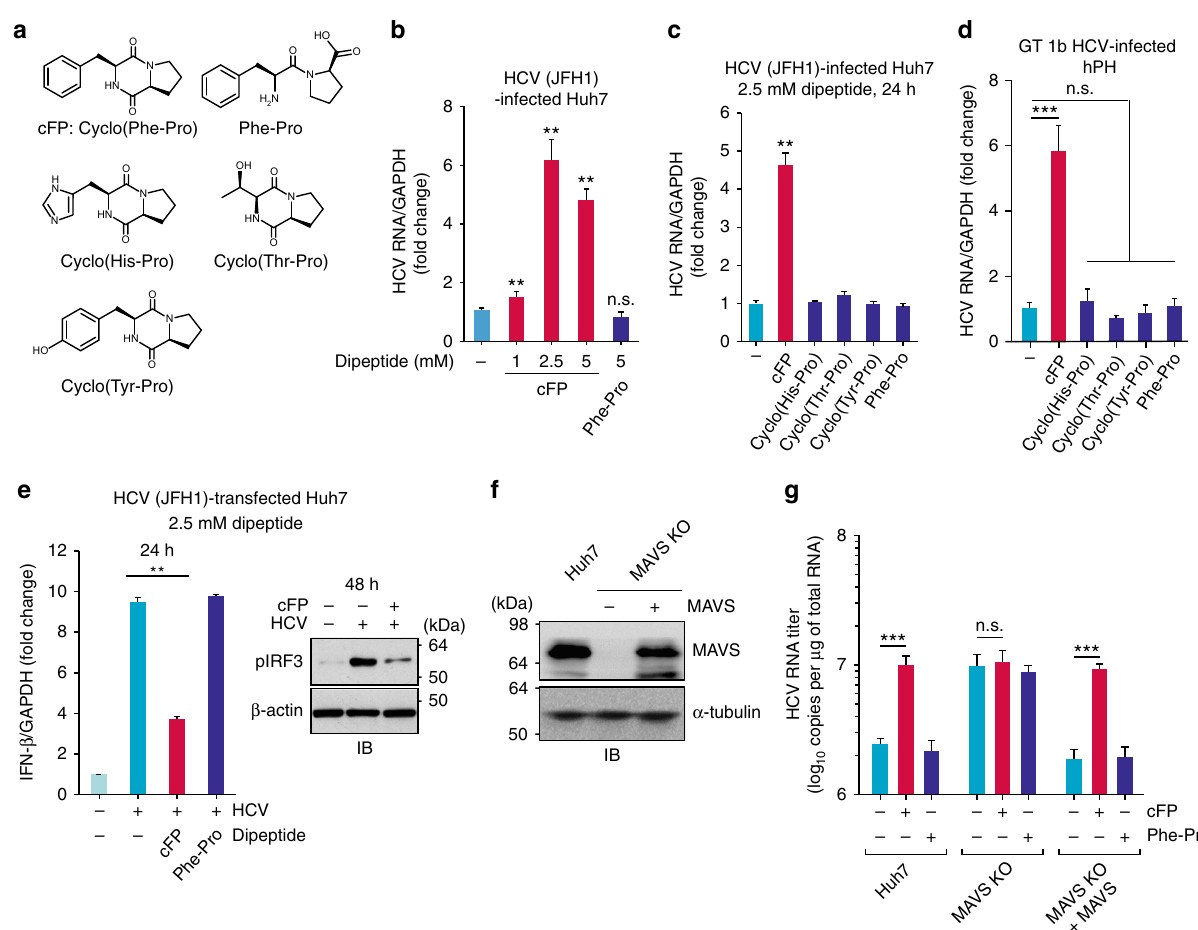
Fig. 1 V. vulni fi cus cFP promotes HCV replication via dysregulation of IFN- β expression. a Molecular structures of various dipeptides used in this study. b RT-qPCR quanti fi cation of HCV genome levels in HCV-infected Huh7 cells treated with the indicated doses of cFP for 24 h. c Quanti fi cation of HCV RNA loads in HCV-infected Huh7 cells treated with 2.5 mM cFP or its derivatives for 24 h. d Quanti fi cation of HCV RNA loads in human primary hepatocytes treated with 2.5 mM cFP or its derivatives at 2 dpi with GT 1b HCV, which was derived from the humanized chimeric uPA-SCID mouse infected with HCV patient sera. e IFN- β mRNA and pIRF-3 expression levels in HCV (JFH1) RNA-transfected Huh7 cells one day after 2.5 mM cFP treatment, assessed by RT- qPCR and immunoblotting, respectively. g HCV (JFH1)-infected Huh7 or MAVS KO Huh7, which was transfected with an empty vector or a plasmid expressing Flag-tagged MAVS, was treated with 2.5 mM cFP or Phe-Pro for 48 h, prior to RT-qPCR quanti fi cation of HCV RNA. f Immunoblotting analysis for MAVS in Huh7 and MAVS KO Huh7, which were transfected as in g . In all panels, data are mean ± s.d. ** P < 0.01; *** P < 0.001; n.s., not signi fi cant; by unpaired two-tailed Student ’ s t RIG-I senses an RNA ligand carrying a 5 ′ -triphosphate moiety, which is an important molecular signature for RIG-I to recognize virally-produced non-self RNA molecules. In addition to this, the poly-U/UC sequence within the HCV 3 ′ -UTR was also identi fi ed as a PAMP motif 24,25 . As expected, HCV 3 ′ -UTR induced IRF-3 activation, as evidenced by IRF-3 phosphorylation and dimeriza- tion (Fig. 2f). This IRF-3 activation was effectively blocked by cFP in HEK293T cells. Overall, our results demonstrate that cFP